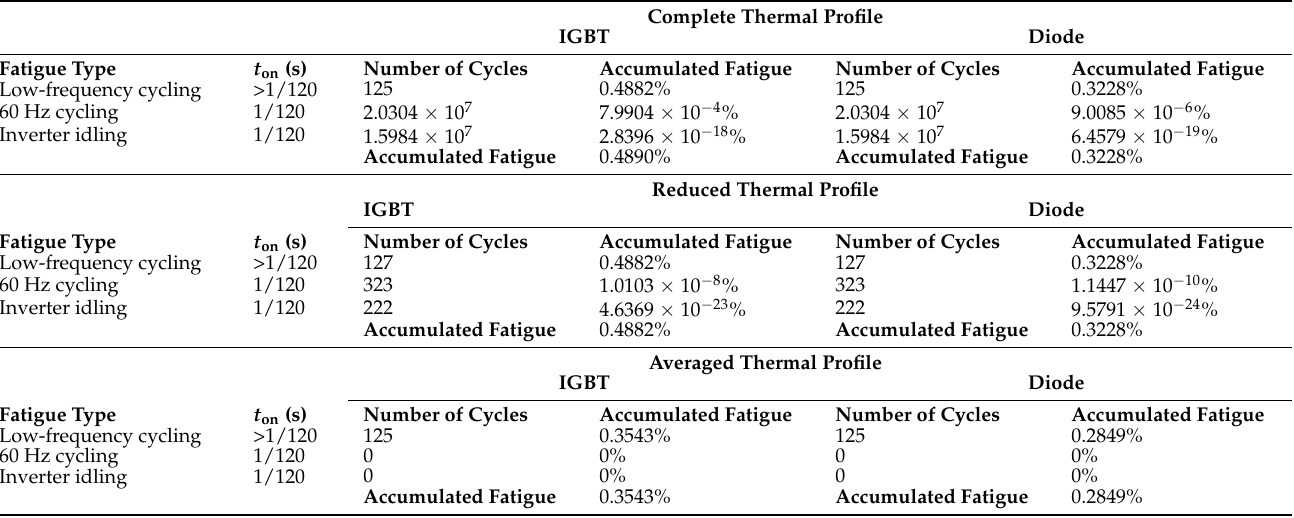
Table 14. Accumulated fatigue results from the 7-day